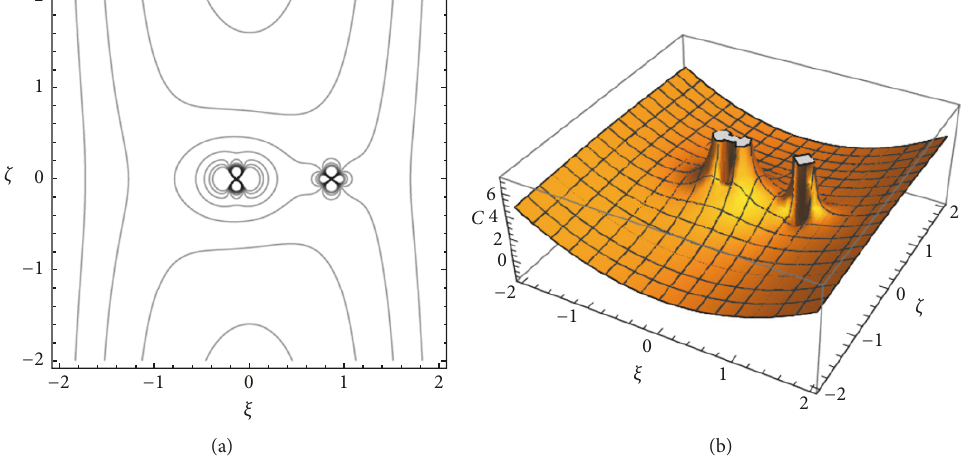
Figure 8: Zero-velocity curves in the ( 𝜉 − 𝜁 ) plane of DP-Leonis for 𝐴 = 0.02, 𝑒 = 0.2,𝑎 = 0.95, 𝜎 1 = 0.04 and 𝜎 2 =